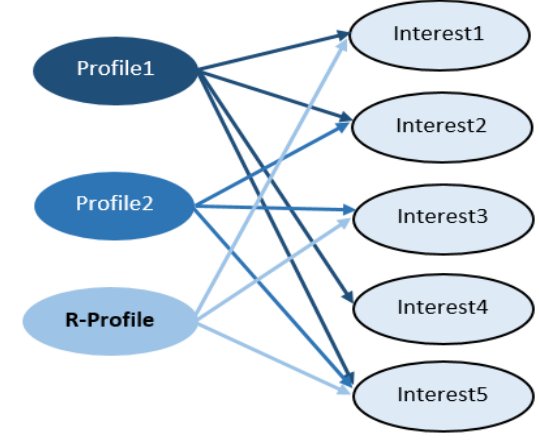
Figure 1. Profiles-Interests Bipartite